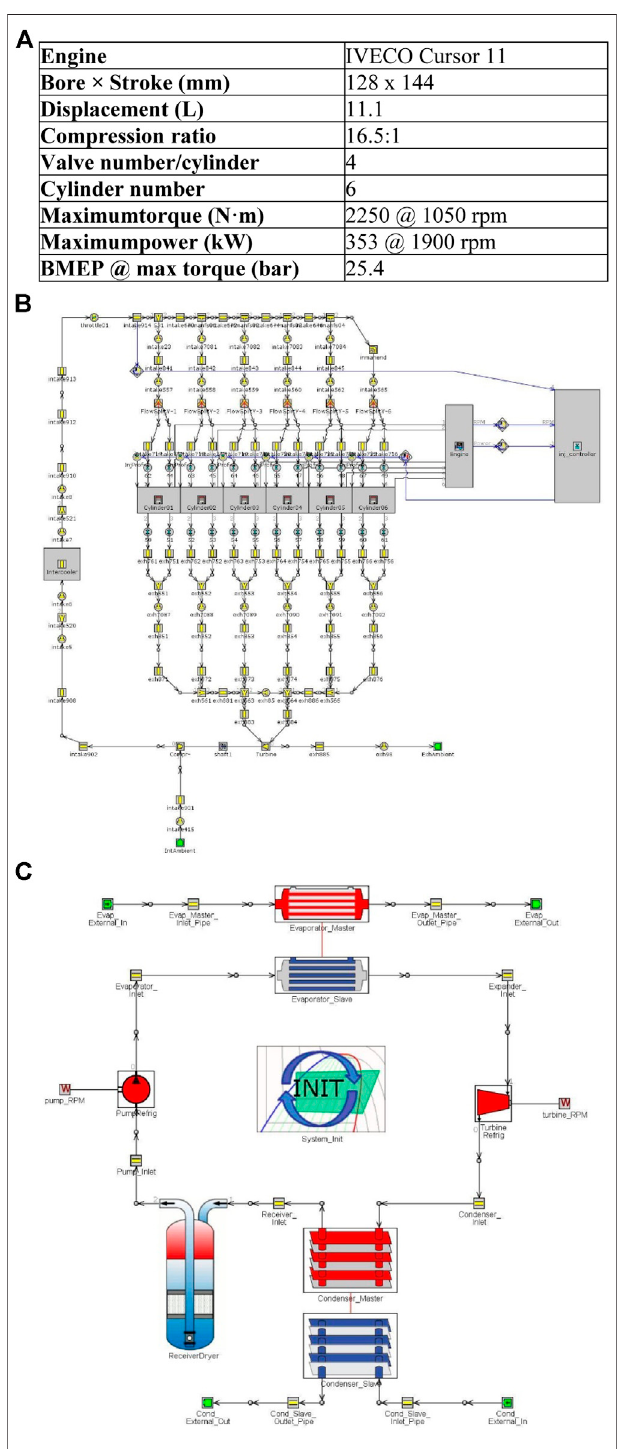
FIGURE 6 | Engine and engine-ORC model speci fi cations (A) IVECO Cursor 11speci fi cations (B) GT-Power enginemodel and (B) GT-Power ORC cycle system model